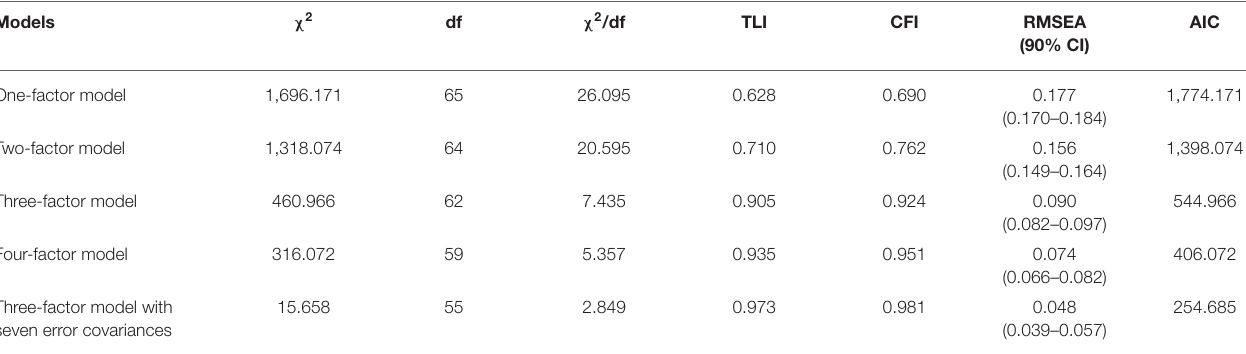
TABLE 2 | Candidate models of the structure of H-UMICS (educational identity); results of CFAs. Models